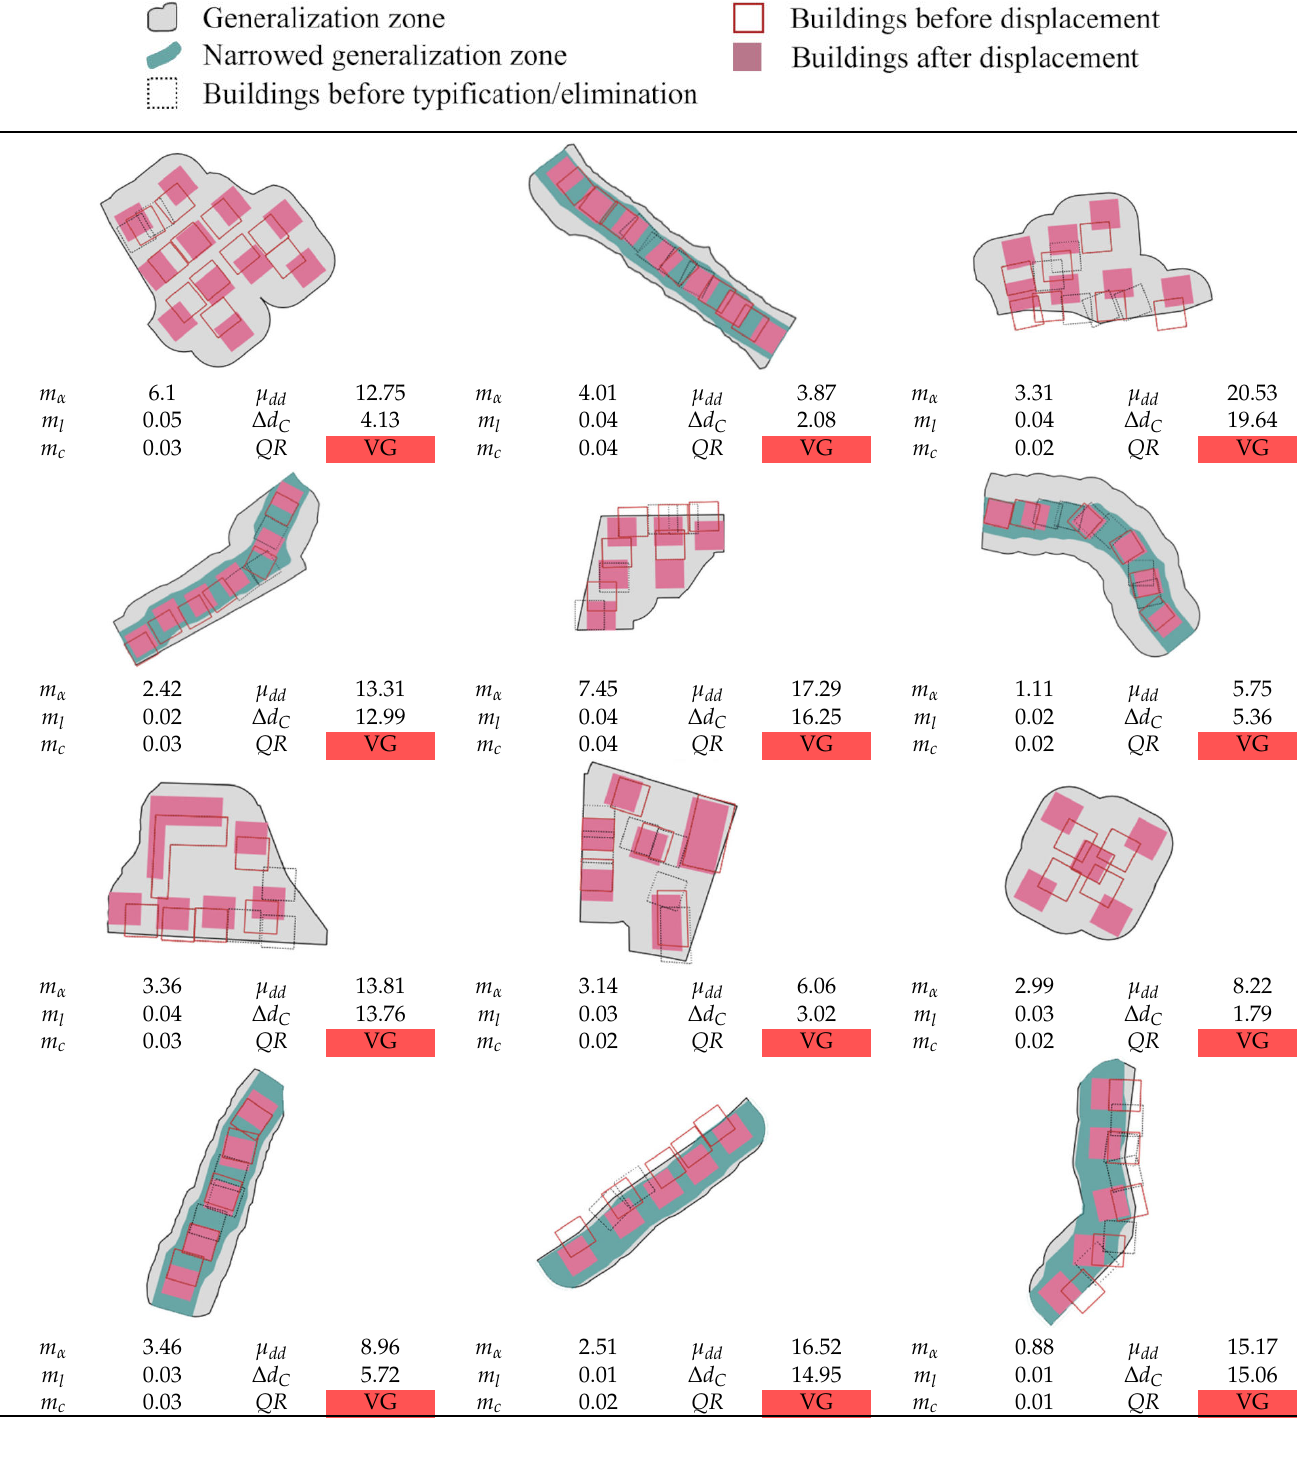
Table A1. Examples of the zonal building displacement including quality evaluation. Description of the symbols are as follows: m α : angle comparison measure, m l : length comparison measure, m c : compactness comparison measure, m θ